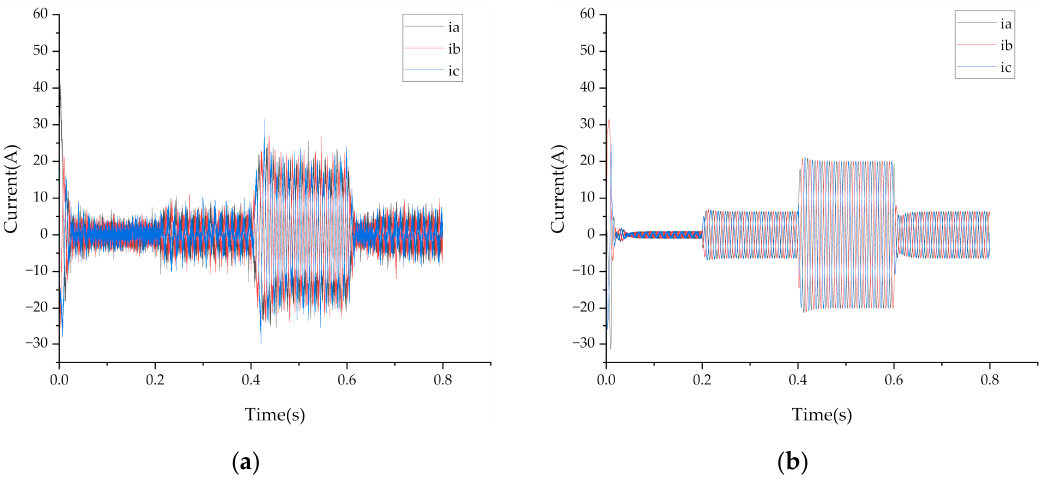
Figure 10. Experimental results of three-phase current. ( a ) Traditional sliding mode observer, ( b ) new sliding mode observer. Table 8. Comparison of experimental results of three-phase current.